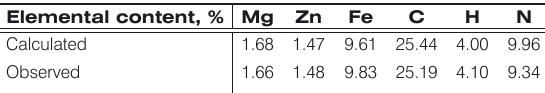
Table 3. The elemental content of the sample